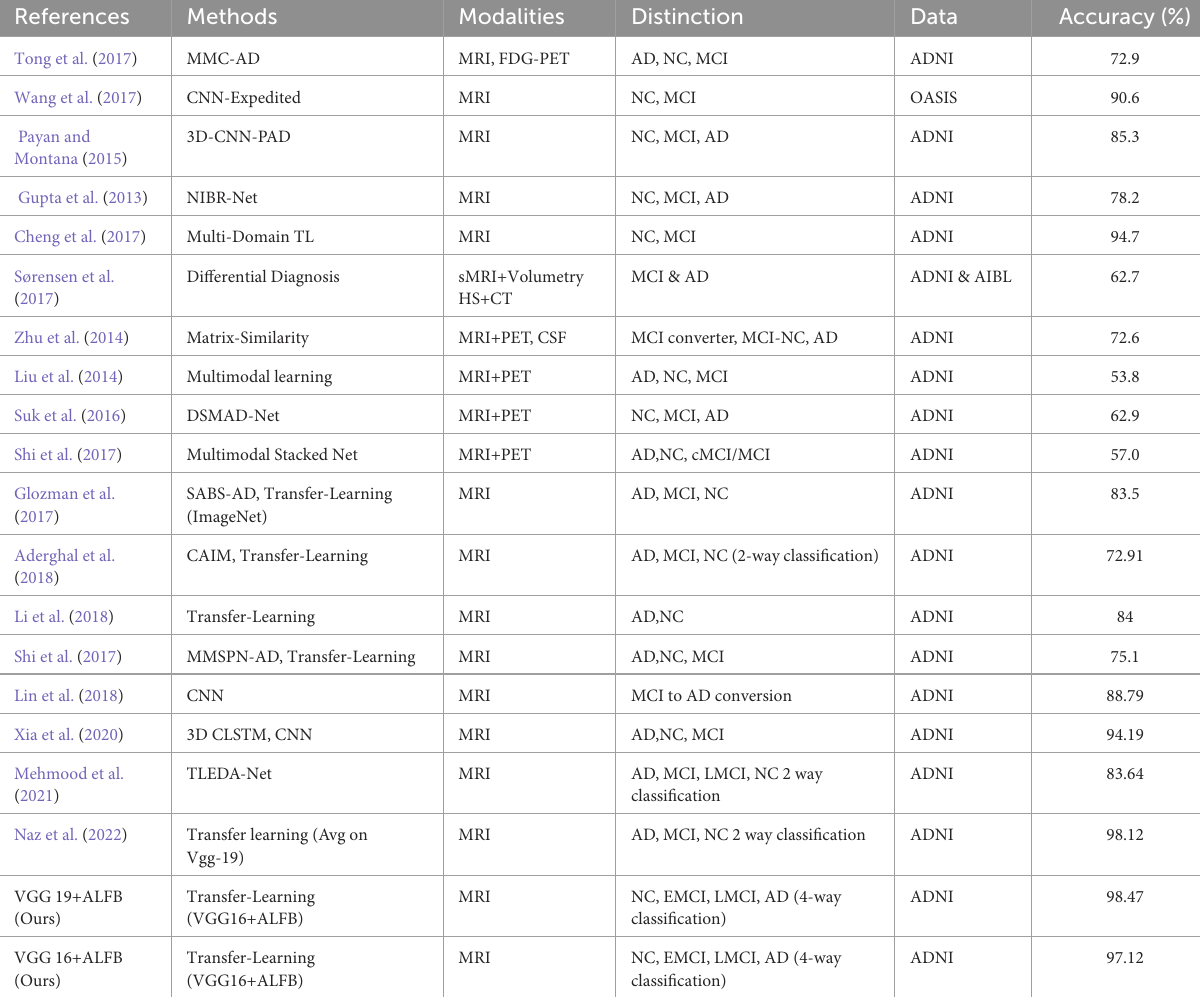
TABLE 3 Comparison of the accuracy of the various state-of-the-art approaches with the proposed work.